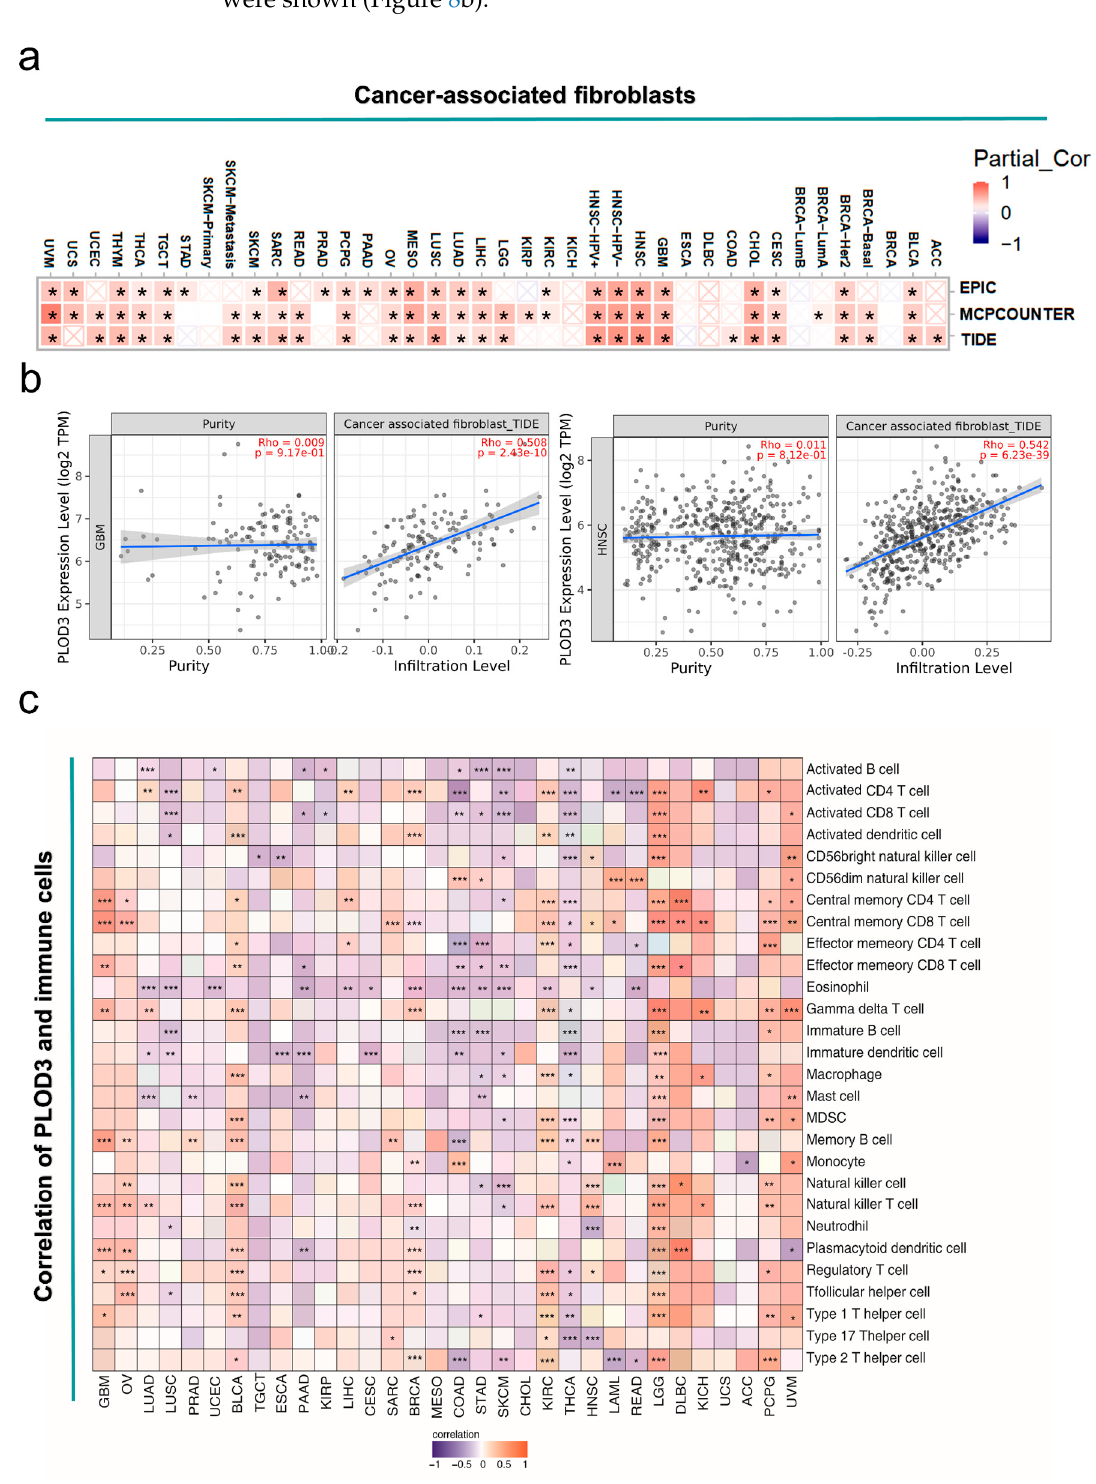
Figure 8. The analysis of relation between PLOD3 expression, immune infiltration of cancer associated fibroblasts and the immune cells. ( a ) Three kinds of algorithms were used to explore the possible correlation between the expression level of the PLOD3 gene and the infiltration level of cancer associated fibroblasts across serious types of cancer in TCGA; ( b ) Scatter plots of cancer associated fibroblasts immune infiltration in different tumors generated based on a certain algorithm; ( c ) Association between PLOD3 expression and different immune cells in different tumors. * p < 0.05, ** p < 0.01, *** p <